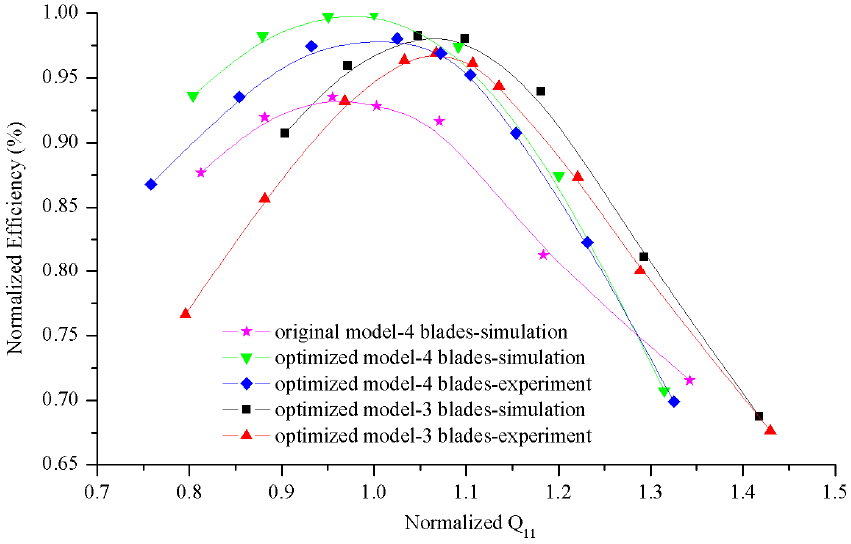
Figure 9. Normalized efficiency vs. normalized Q 11 for the ebb turbine mode.